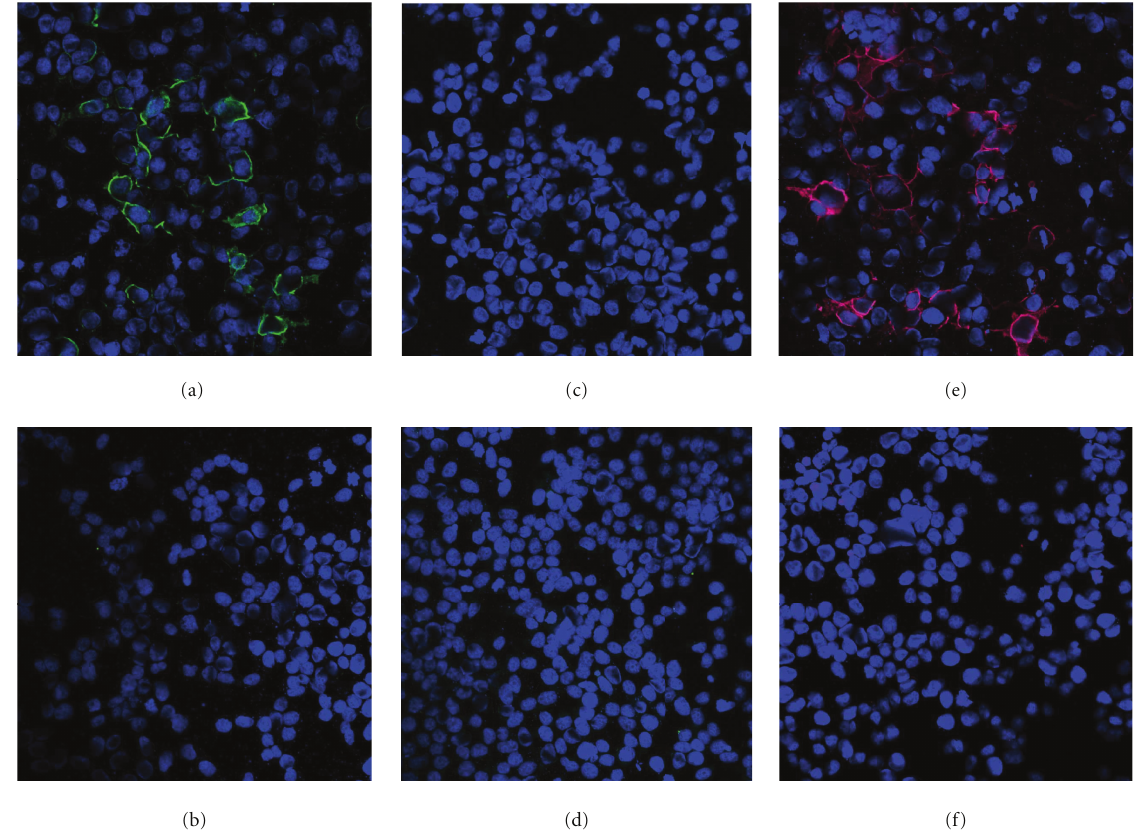
F 3: Immuno�uorescence staining patterns of HEK293 expressing soluble liver antigen. HEK293 expressing soluble liver antigen (SLA) and wild-type HEK293 were incubated with either 1:100 diluted human serum or 1:100 diluted anti-SLA rabbit serum and bound antibodies were visualized with either anti-human IgG FITC (green) or anti-rabbit IgG Cy3 (red) conjugates. Nuclear DNA was stained with TO-PRO-3 (blue). (a, c, e) HEK293-SLA; (b, d, f) untransfected HEK293; (a & b) representative anti-SLA positive serum from a patient with autoimmune hepatitis; (c & d) representative anti-SLA negative serum from a healthy blood donor; (e & f) anti-SLA rabbit